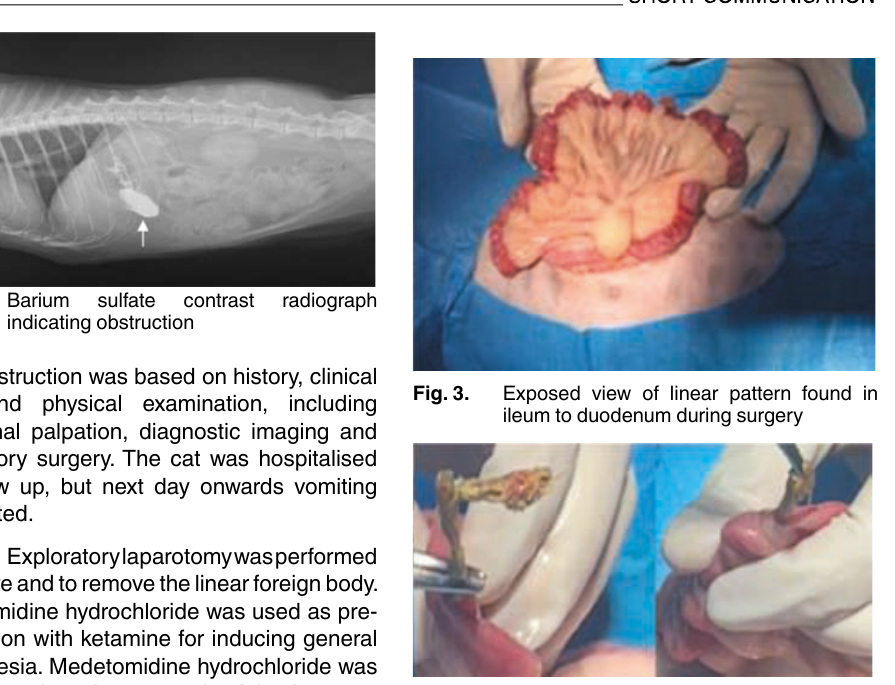
Fig. 4. Surgical removal of the linear foreign